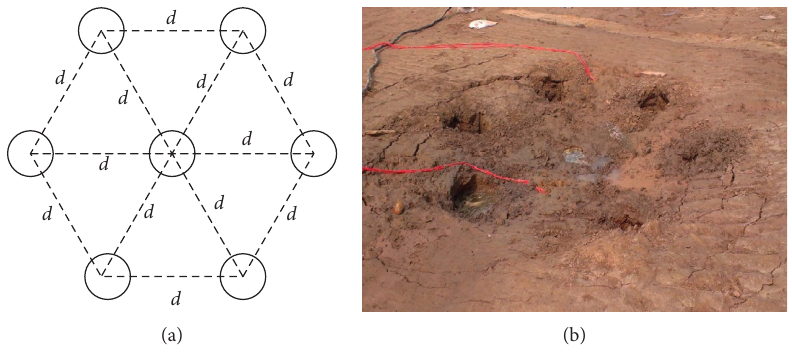
Figure 5: Layout of testing points in the resonance method ( d � 1.8m).